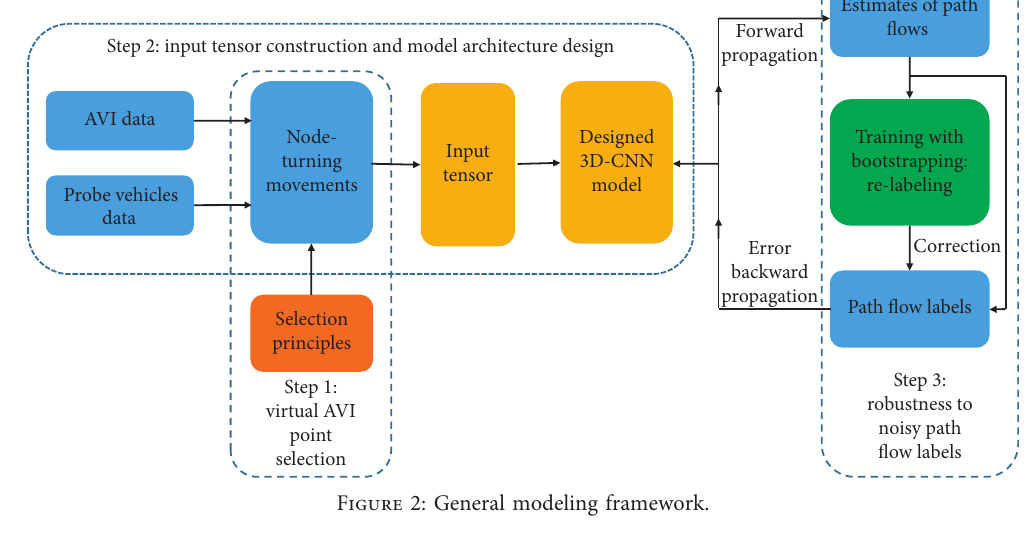
Figure 2: General modeling framework.